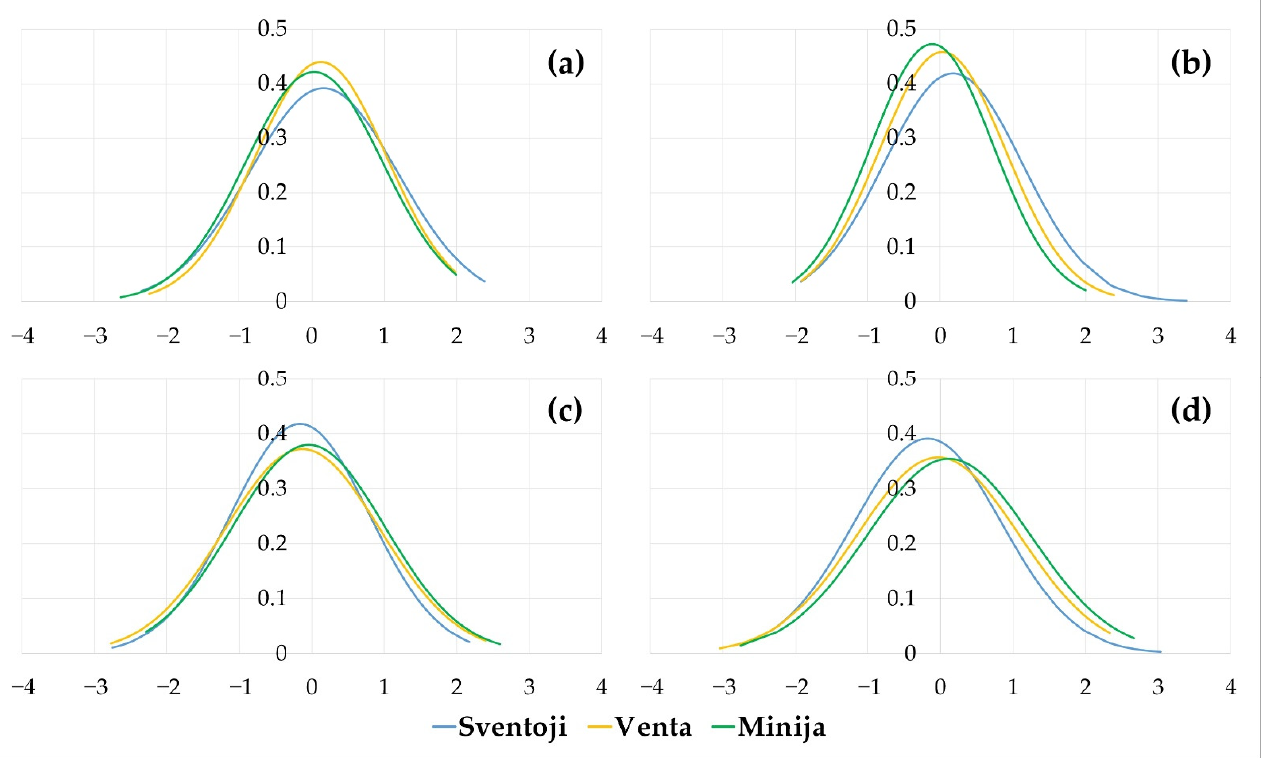
Figure 16. SDI index with 12-month accumulation period: ( a ) RCP 4.5 near future; ( b ) RCP 8.5 near future; ( c ) RCP 4.5 far future; ( d ) RCP 8.5 far future. future; ( c ) RCP 4.5 far future; ( d ) RCP 8.5 far